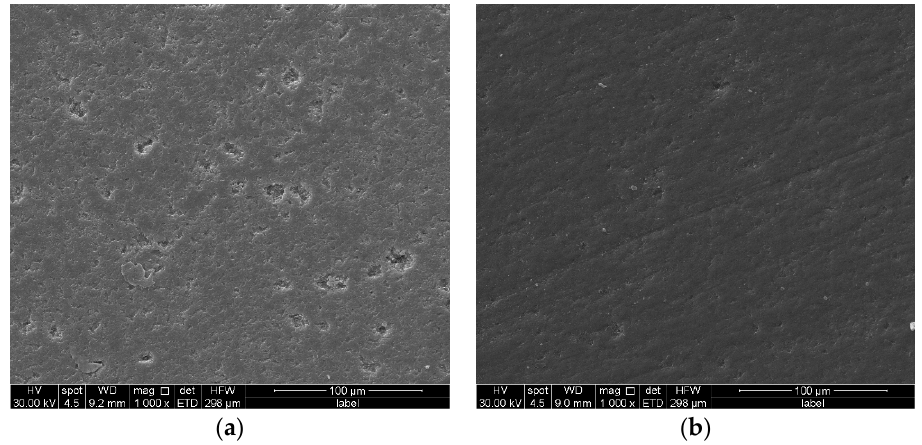
Figure 10. Worn surfaces of the SN10 pin against the PEEK disc in artificial seawater at the following different speeds: ( a ) 0.52 m/s; ( b ) 1.73 m/s.